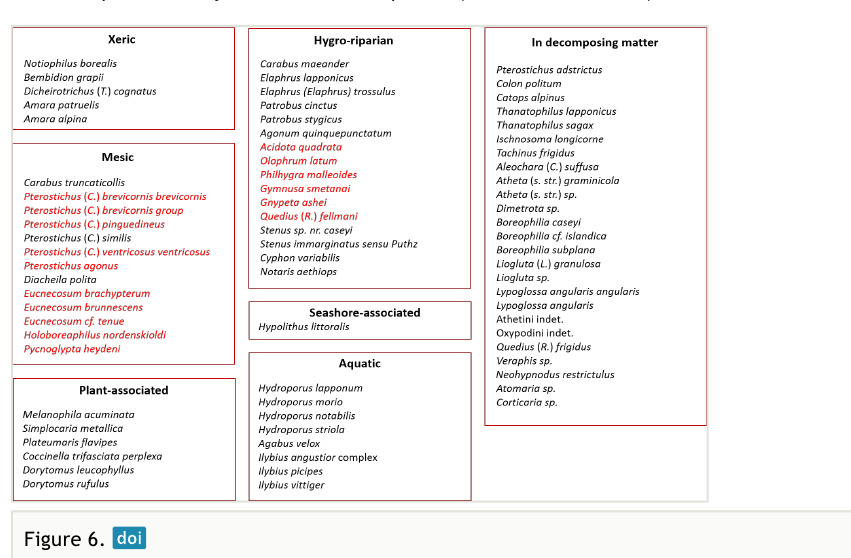
Grouping of identi fi ed taxa according to their habitat/ecology. In red font are those taxa that belong to mesic, hygrophilous and riparian environments, but that are known to be associated with microhabitats available in decaying plant matter (e.g. leaf litter, fl oor debris).